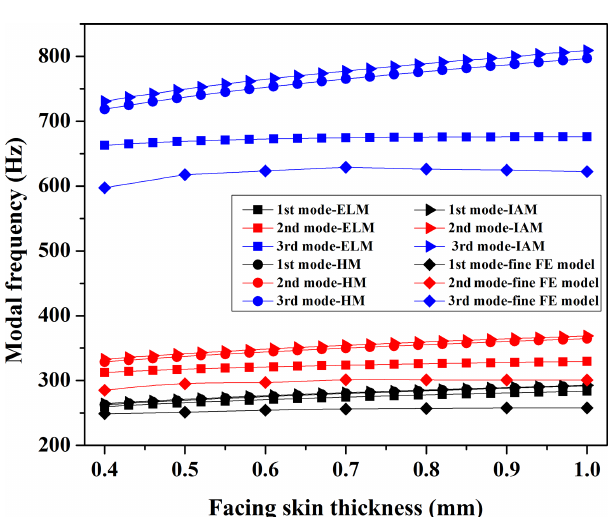
Figure 5. Effect of the facing skin thickness on the dynamic char-